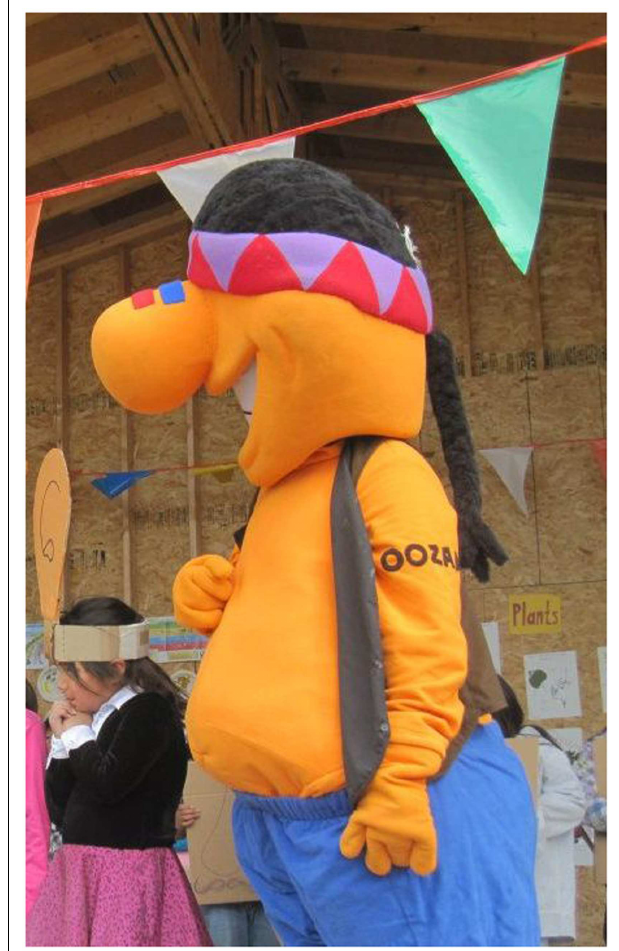
FIGURE 3 | Chief Sugar Daddy at community health promotion